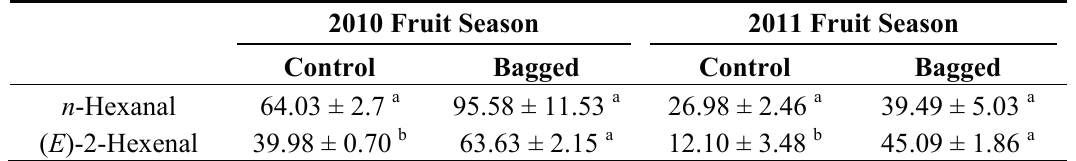
Table 1. Effects of bagging treatment on the concentrations of n -hexanal and ( E )-2-hexenal (µg·g − 1 FW) in peach fruit skin at harvest.